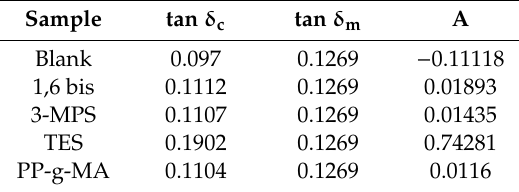
Table 2. Glass fiber surface treatment coupling agents on the adhesion of the interface.